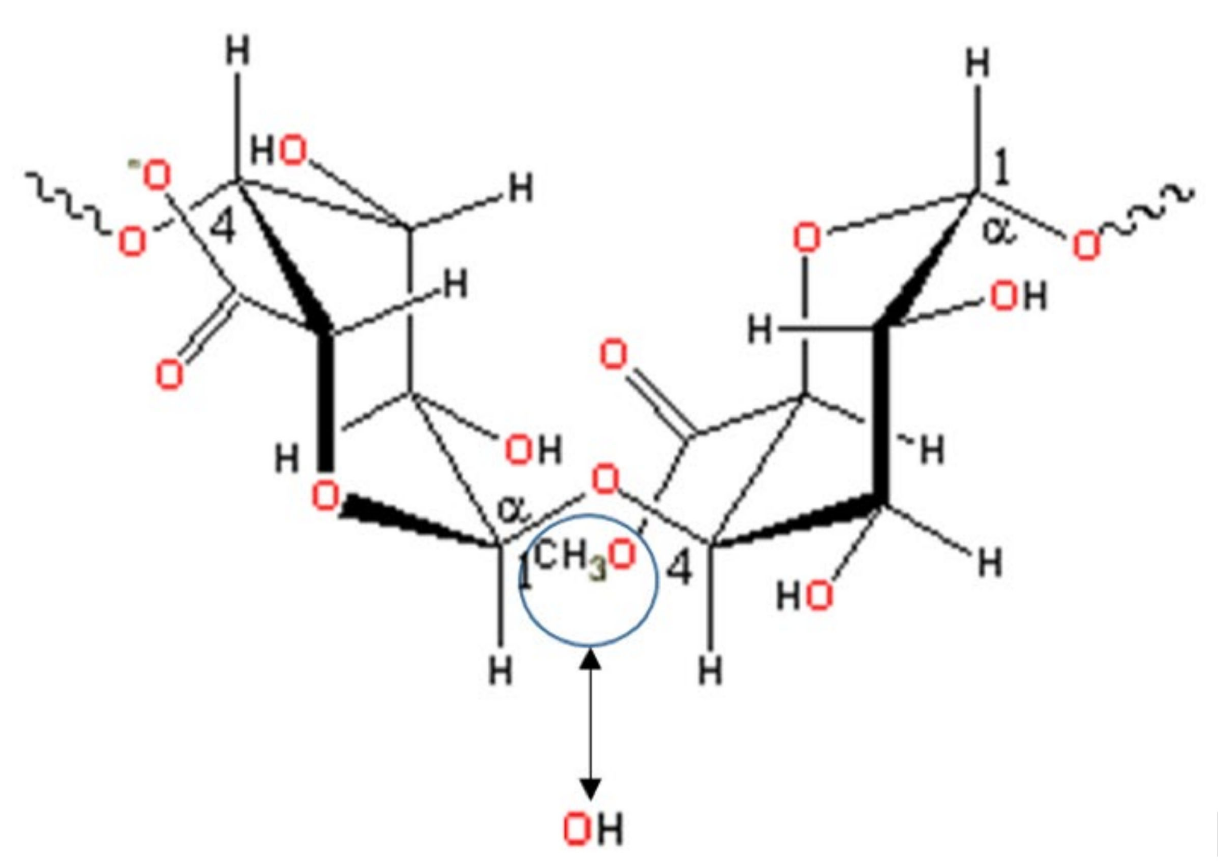
Figure 2. The schematic molecular unit structure of high methoxyl pectin (HMP) with –OCH 3 and low methoxyl pectin (LMP) when substituted with –OH Adapted from